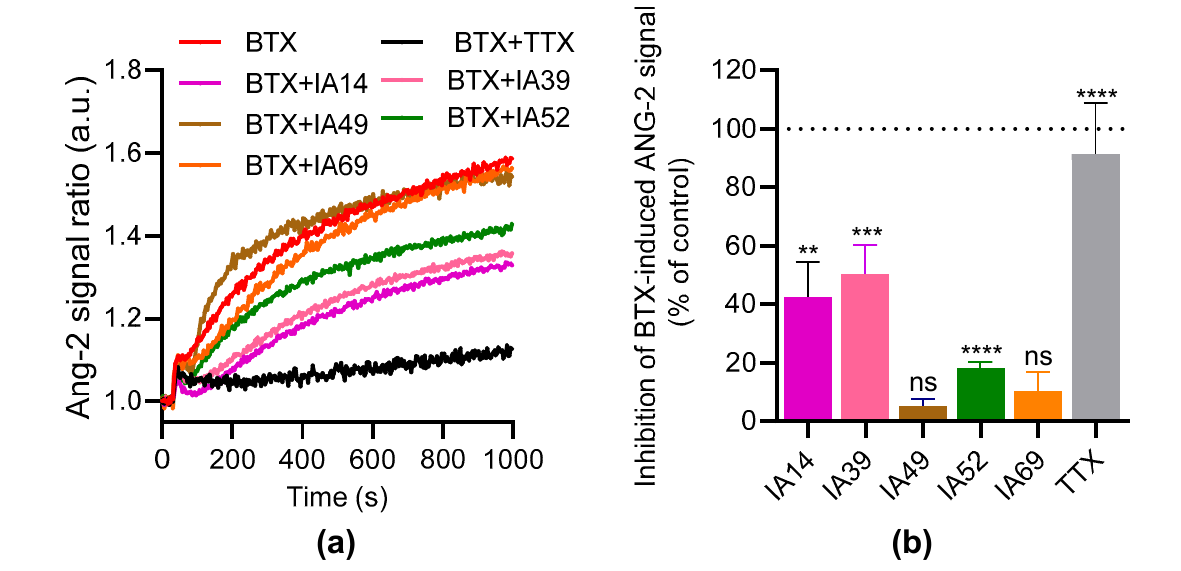
Figure 6. Effects of oxostephanine, liriodenine, thalmiculine, bebeerine, and protopine on the ANG-2 signal induced by BTX in HEK293-hNa V 1.3 cells. ( a , b ) Representative kinetic traces illustrating the fluorescence emission of ANG-2 probe induced by the injection of BTX (3 µ M) without or with oxostephanine (IA14), liriodenine (IA39), bebeerine (IA52), thalmiculine (IA49), and protopine (IA69) at 10 µ M each. TTX (1 µ M) was used as control. ( c , d ) The histogram bars represent the inhibition rate (in %) of each IA at 10 µ M on the ANG-2 fluorescence signal induced by BTX. Normalized data were calculated as described for the VSP signal. Data are mean ± SEM of 3–5 independent experiments. Significance was evaluated by two-tailed unpaired t -tests between each group, with zero as a hypothetical value. **, p < 0.01; ***, p < 0.001; ****, p < 0.0001; ns: not significant.